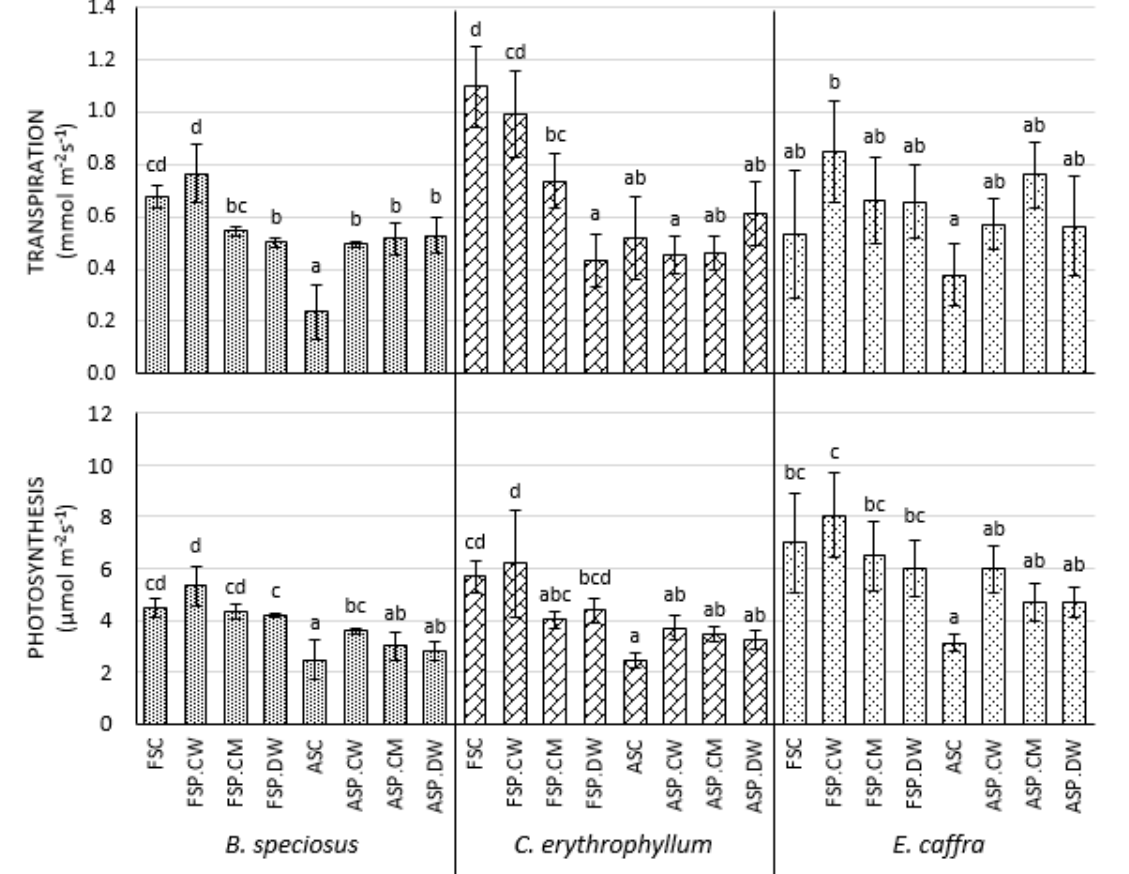
Figure 2. Effect of cathodic water, calcium magnesium solution and deionized water seed invigoration on the photosynthesis of Bolusanthus speciosus, Combretum erythrophyllum and Erythrina caffra . Bars with different letters in each species and for each parameter (photosynthesis/transpiration) investigated are significantly different ( p < 0.05). Abbreviations as for Figure 1.